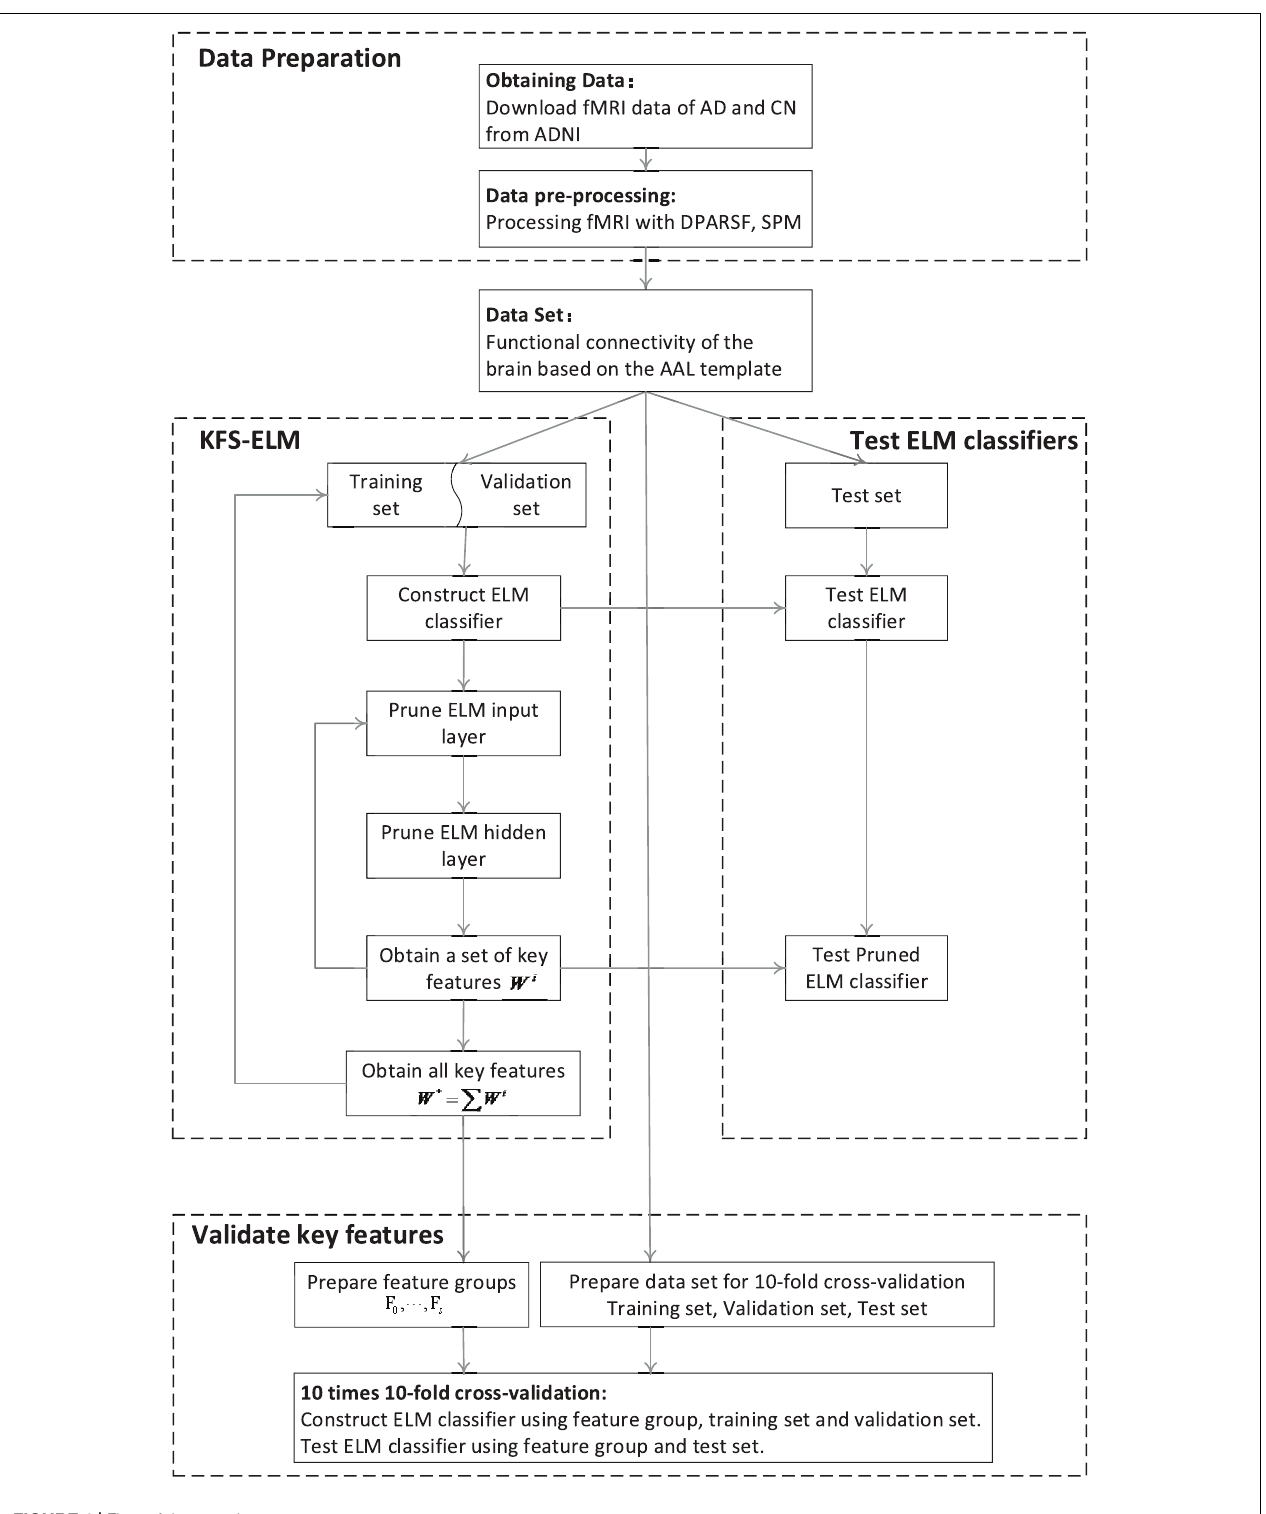
FIGURE 1 | Flow of the